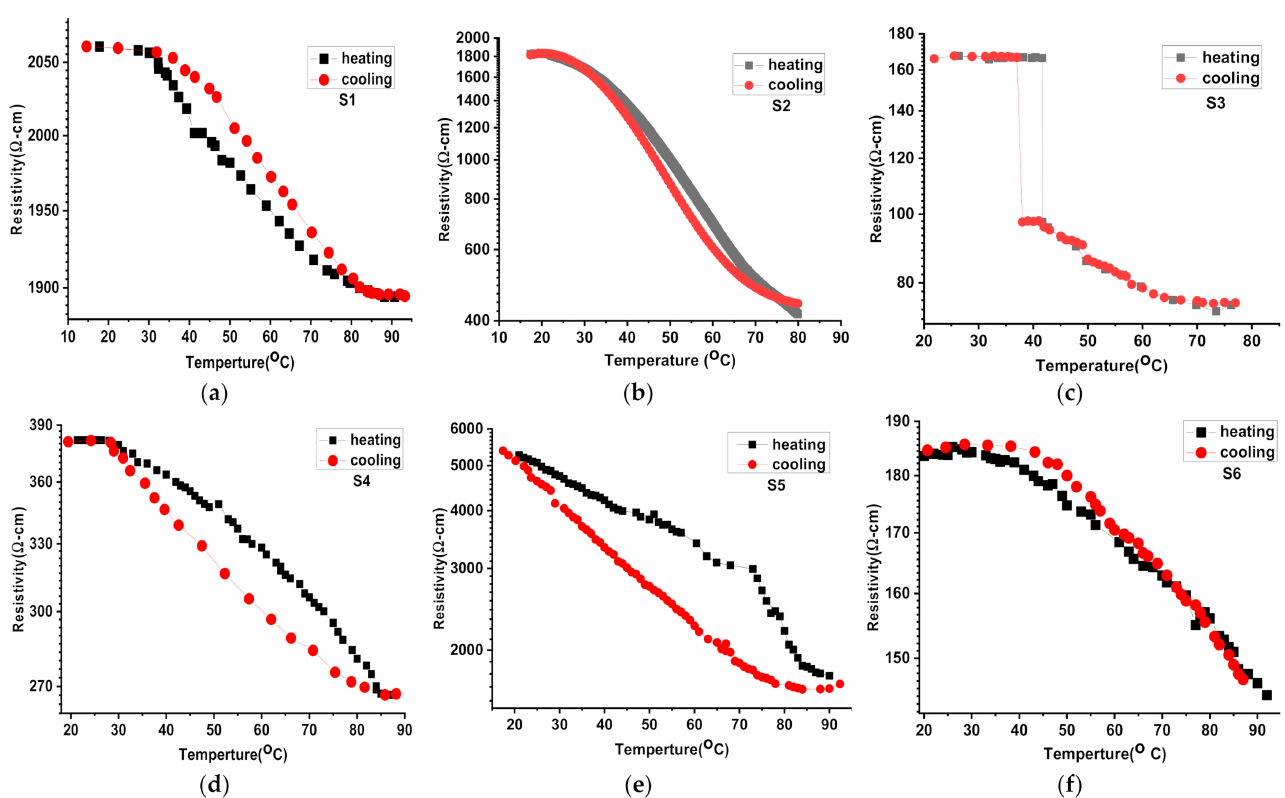
Figure 8. Electric properties and phase transition characterization measurements of the prepared S1–S6 ( a – f ) thin